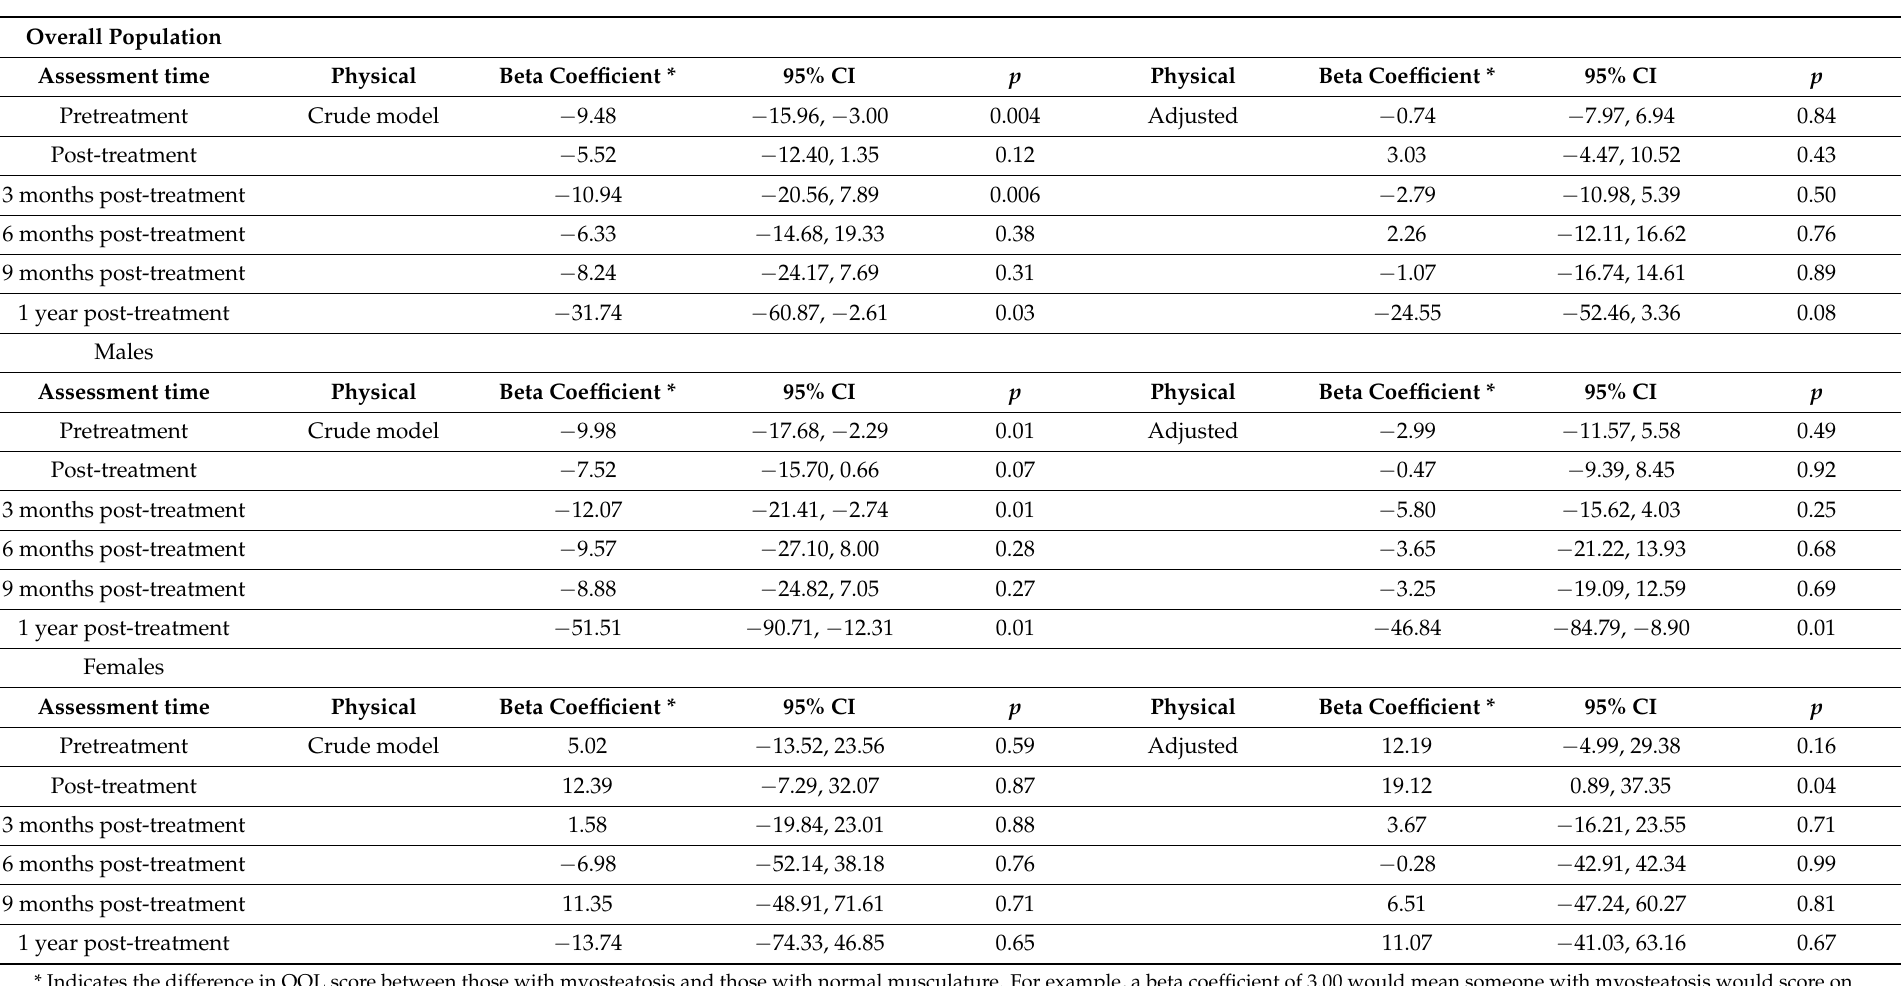
Table 2. Average difference in physical QOL score comparing those with myosteatosis to those with normal skeletal muscle density from pretreatment to one year after treatment. Overall